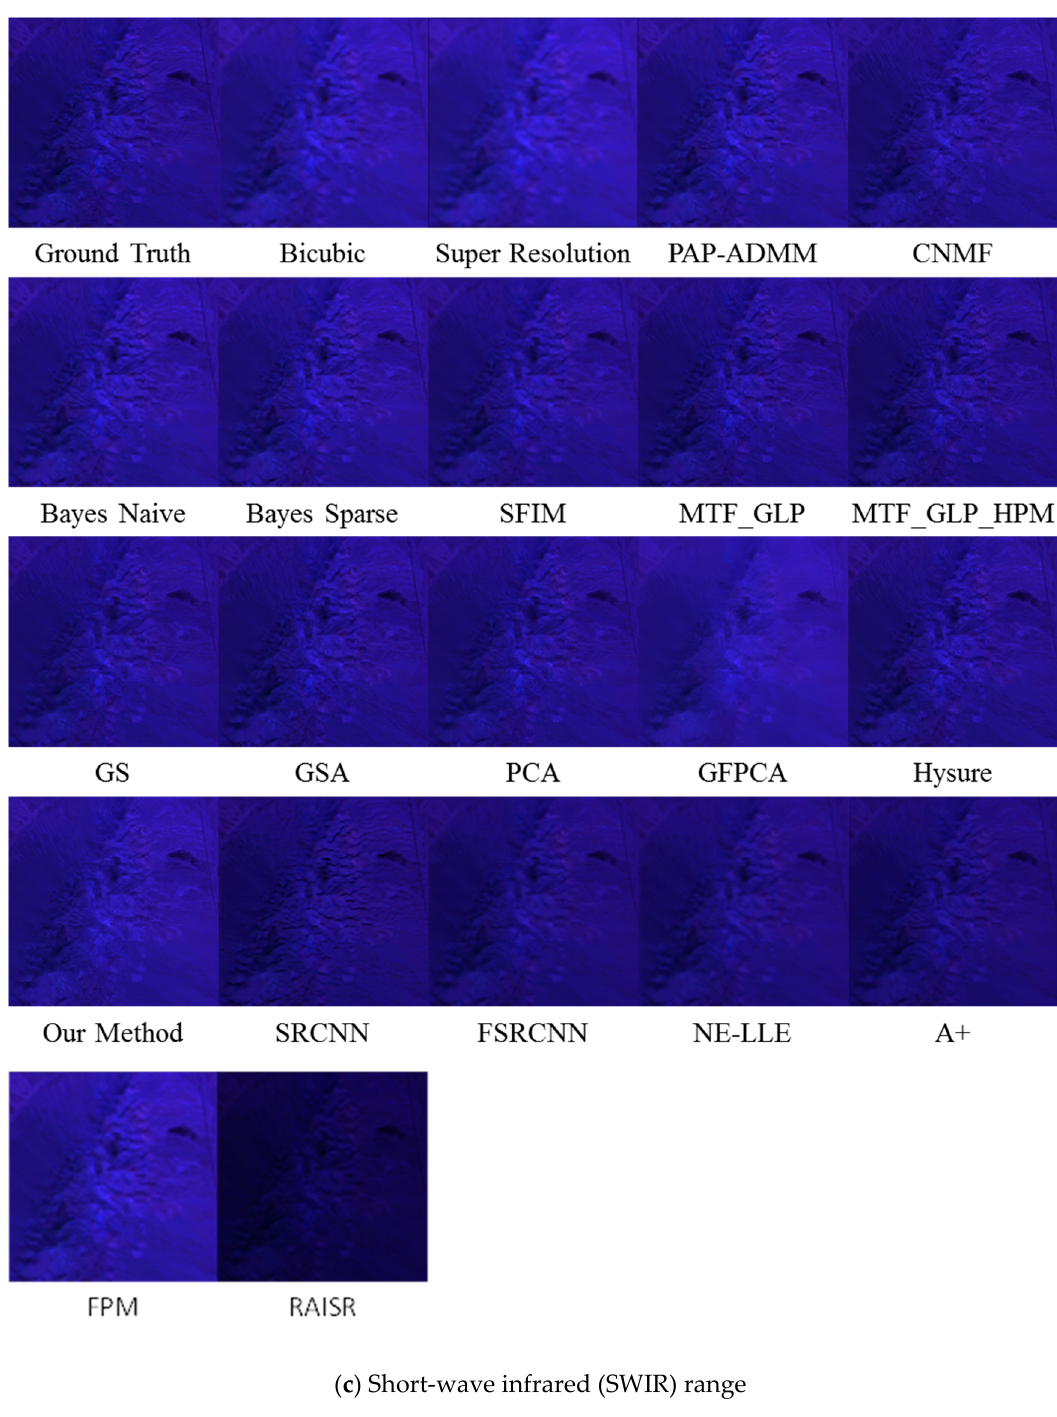
Figure 9. Fused AVIRIS images using different methods. ( a ) Visible range, ( b ) VNIR range, and ( c ) SWIR range.